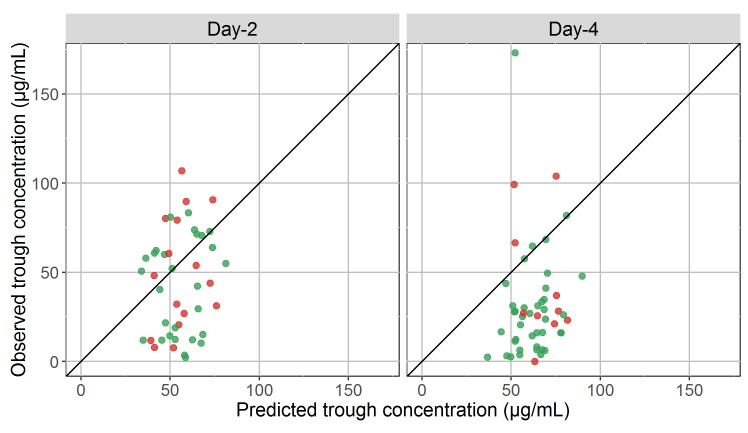
Observed trough concentrations (y-axis) versus predicted trough concentrations (x-axis) at Day-2 (left, n = 44 observations) and Day-4 (right, n = 50) after treatment initiation.Red points represent concentrations measured in patients who died during the trial, green points represent concentrations measured in those who survived.